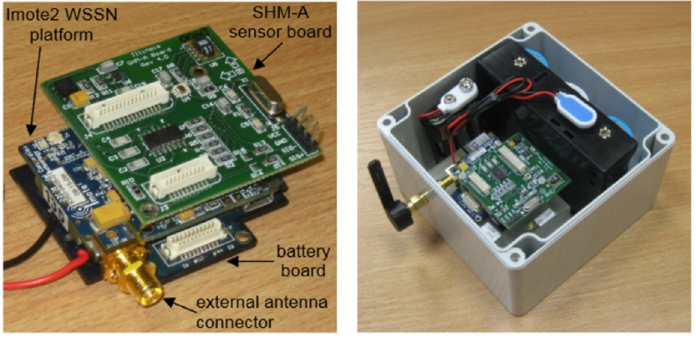
Figure 9. Wireless smart sensor node, WSSN [75].